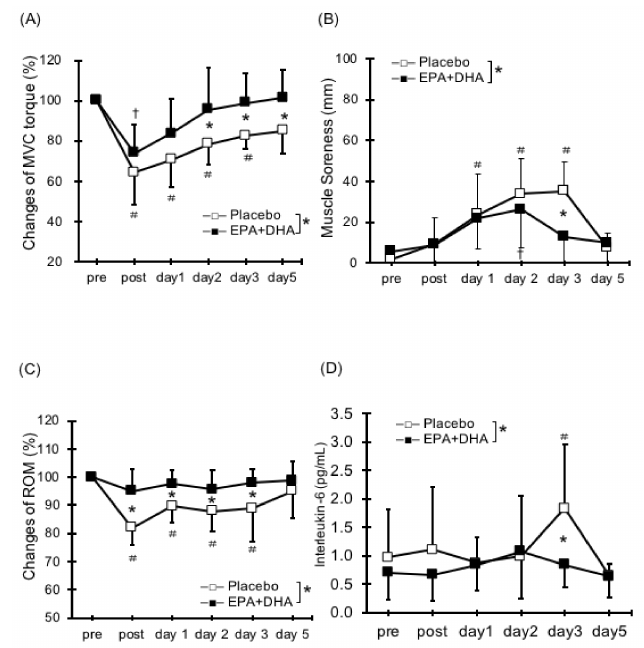
Figure 1. Changes (means ± SD) in: maximal voluntary isometric contraction (MVC) torque ( A ); muscle soreness ( B ); range of motion (ROM) ( C ); and Interleukin (IL)-6 ( D ), before (pre), immediately after (post), and 1, 2, 3, and 5 days after eccentric contractions in EPA group and placebo. * ( p < 0.05); significant difference between groups, † ( p < 0.05); significant difference from pre-exercise value in EPA group, # ( p < 0.05); significant difference from pre-exercise value in placebo group (data are from Tsuchiya et al.,